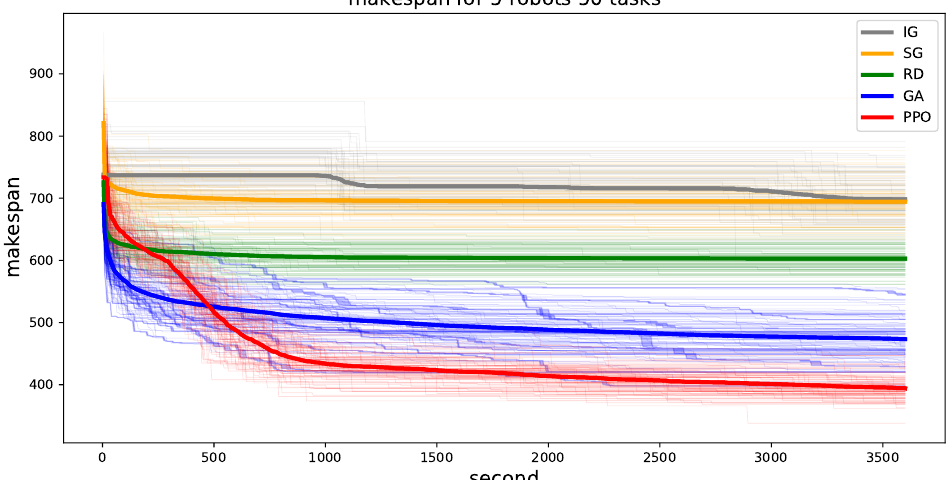
Figure 7. Minimum makespan until the indexed time for 100 problem instances. The environment has 5 robots and 50 tasks. Thin lines indicate each instance problem and the bold lines indicate the average of all samples. Best viewed in